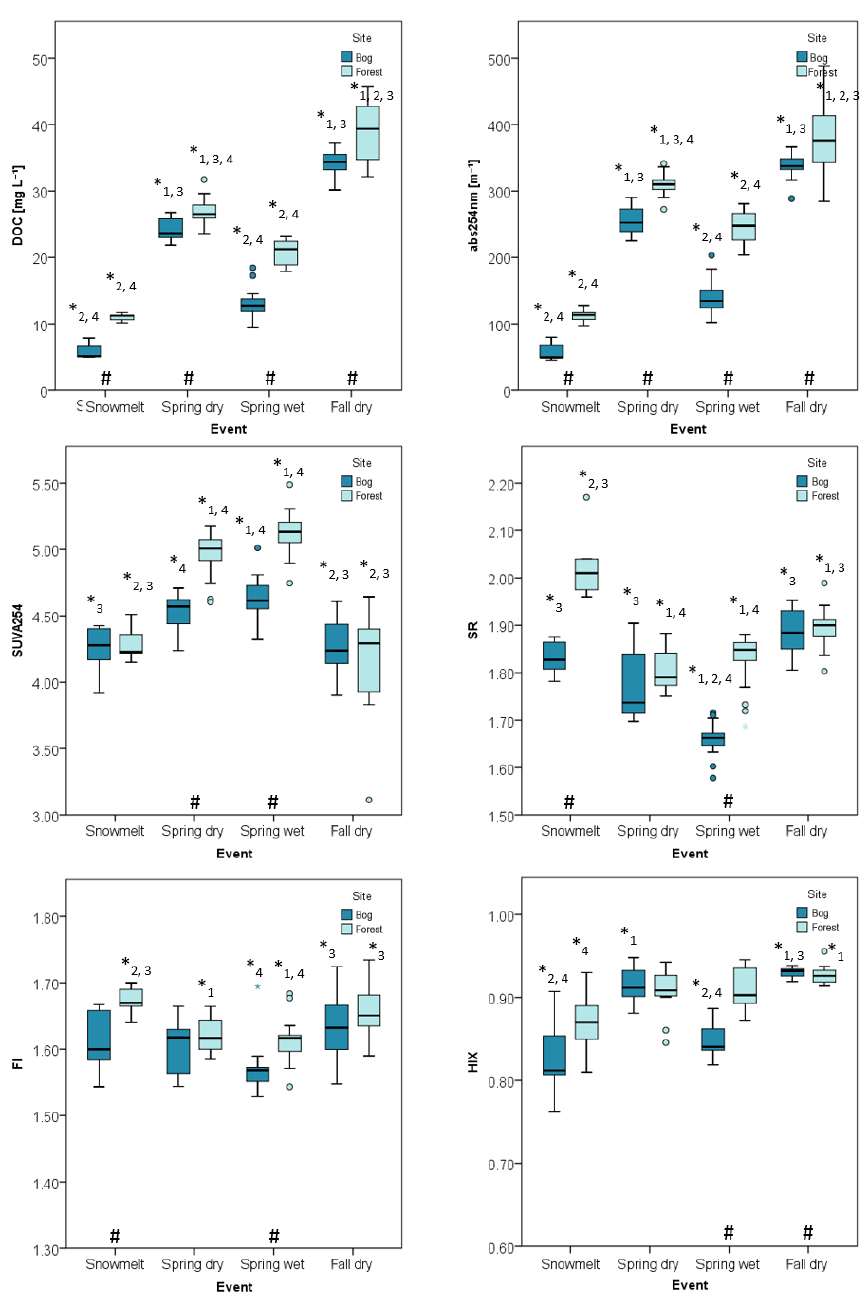
Figure 3. Box plots of SUVA, S R , HIX, DOC concentrations, abs 254nm and FI during events. Dark blue bars indicate the bog site, lighter blue bars the forested site. Asterisks indicate a significant difference between events (Kruskall–Wallis; ρ < 0.05), which are indicated by added numbers: 1 – snowmelt, 2 – spring dry, 3 – spring wet, 4 – fall dry. Significant differences between the bog and the forested site at an event (Mann–Whitney; ρ < 0.05) are indicated by a hash. A table of descriptive statistics for each event can be found in the Supplement.